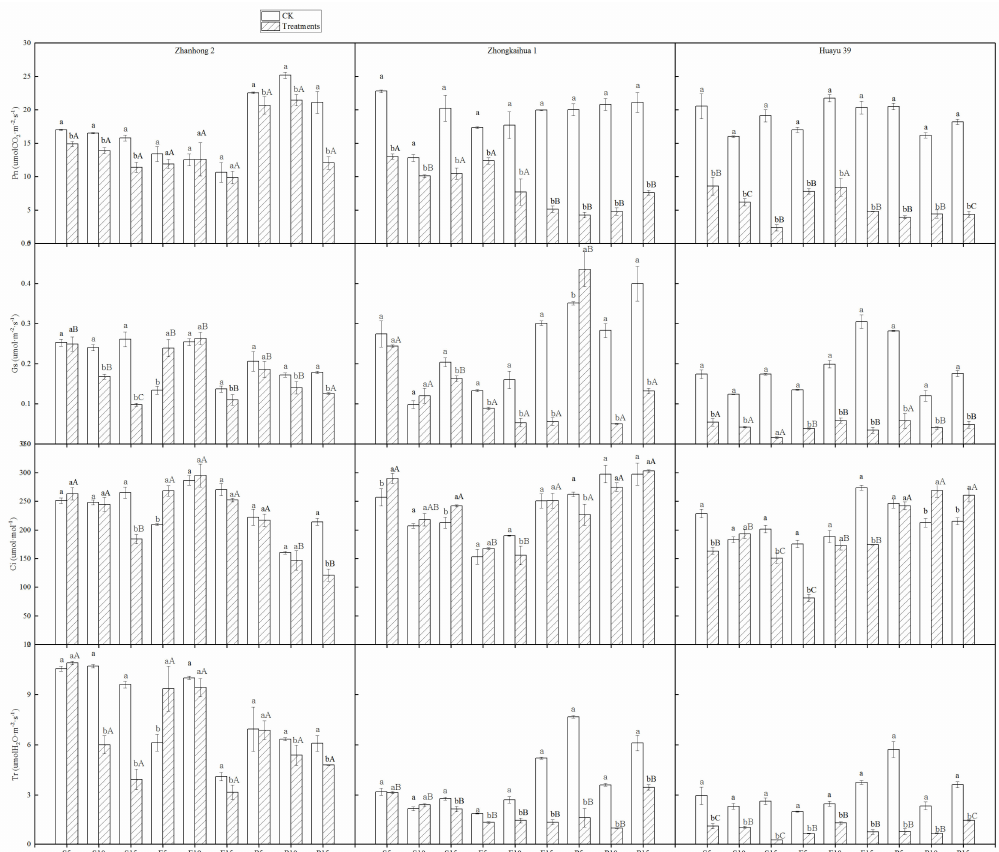
Figure 6. The e ff ects of the di ff erent durations of waterlogging treatments on the photosynthetic parameters of the three peanut ecotypes at di ff erent growth stages. Data are presented as the average value ( n = 3). Di ff erent lowercase letters indicate statistically significant di ff erences between the treatments ( p < 0.05) in the same genotype, as determined by the least significant di ff erence test. A, B, C indicate statistically significant di ff erences between di ff erent ecotypes under same waterlogging stress treatments ( p < 0.05), as determined by the least significant di ff erence test. S5, S10, S15, F5, F10, F15, P5, P10, P15 indicate the waterlogging stress for 5, 10, and 15 days at the seedling, flowering, and pod-filling stages, respectively; CK: control (plants without waterlogging stress);